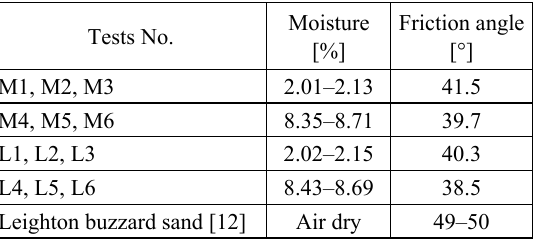
Table 2. Calculation results for friction angle Tests